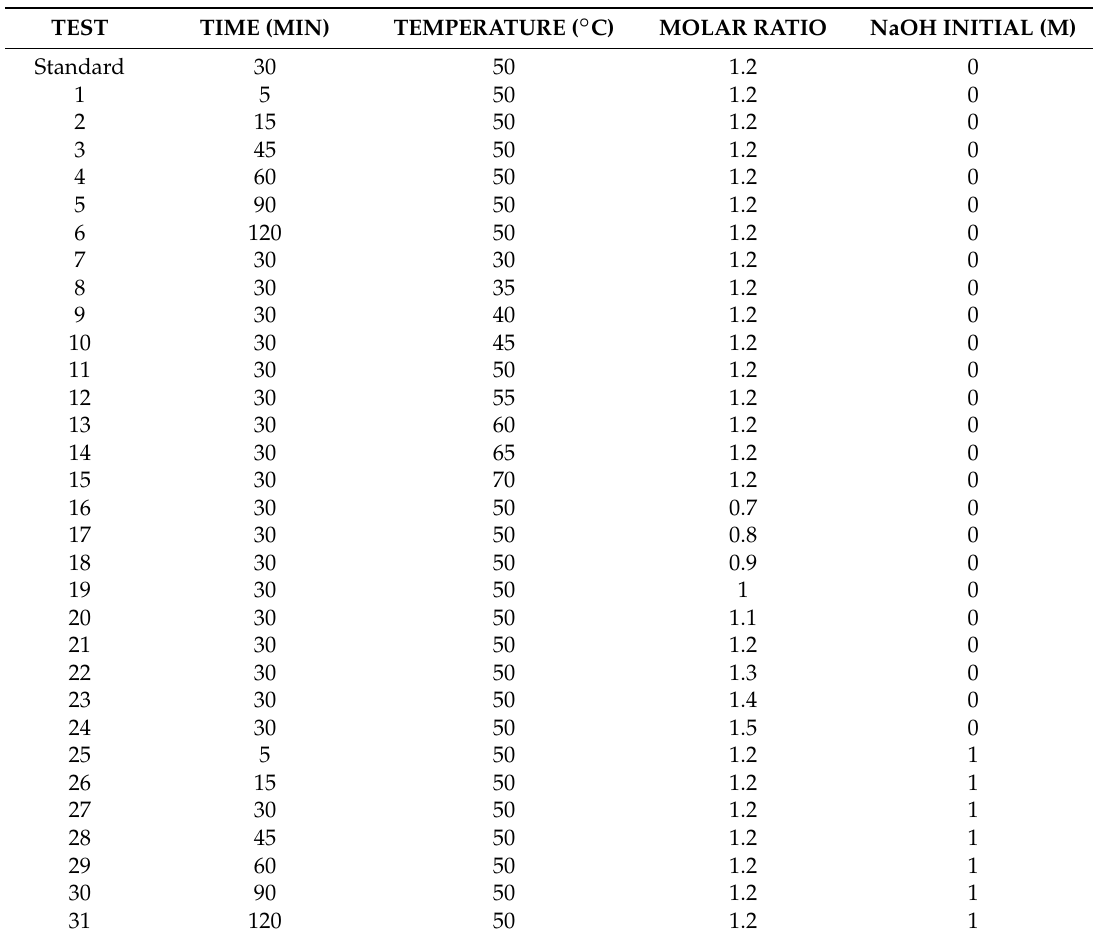
Table 1. Matrix of the experiments carried